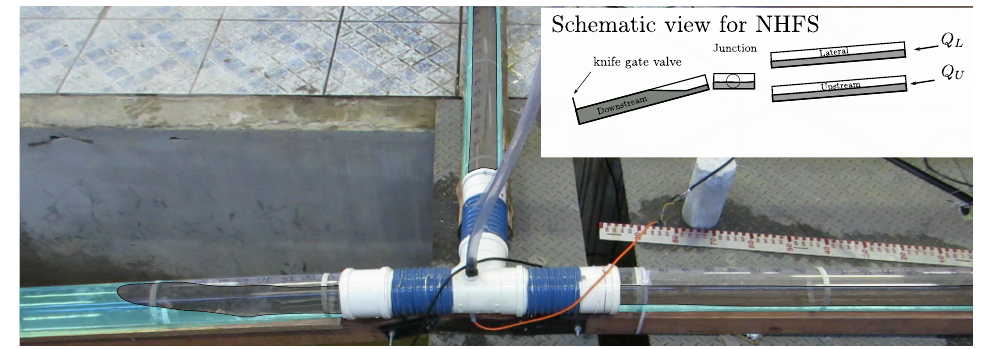
Figure 4. Example of the NHFS mode showing the pressurization process following the closure of the knife gate